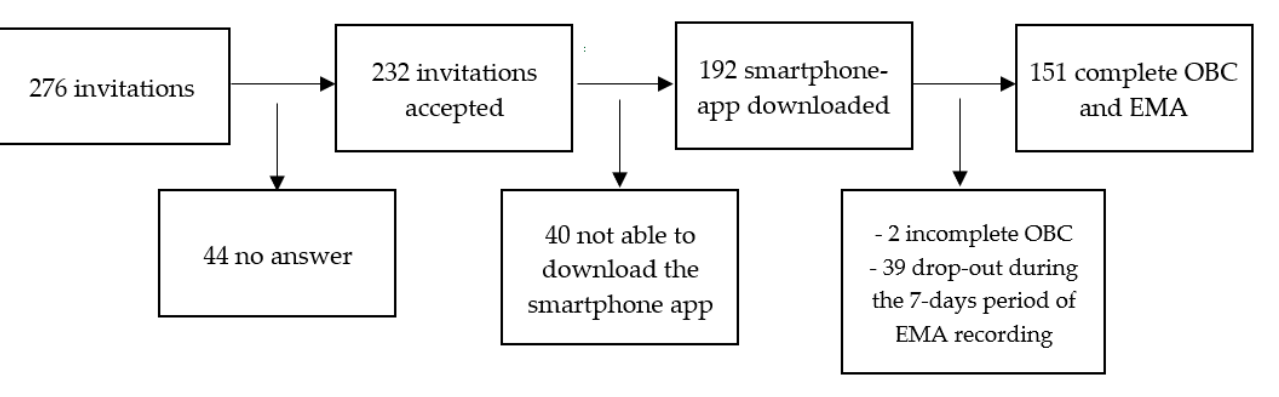
Figure 1. Flowchart of the participant-recruitment process. OBC: Oral Behaviours Checklist; EMA: Ecological Momentary Assessment.